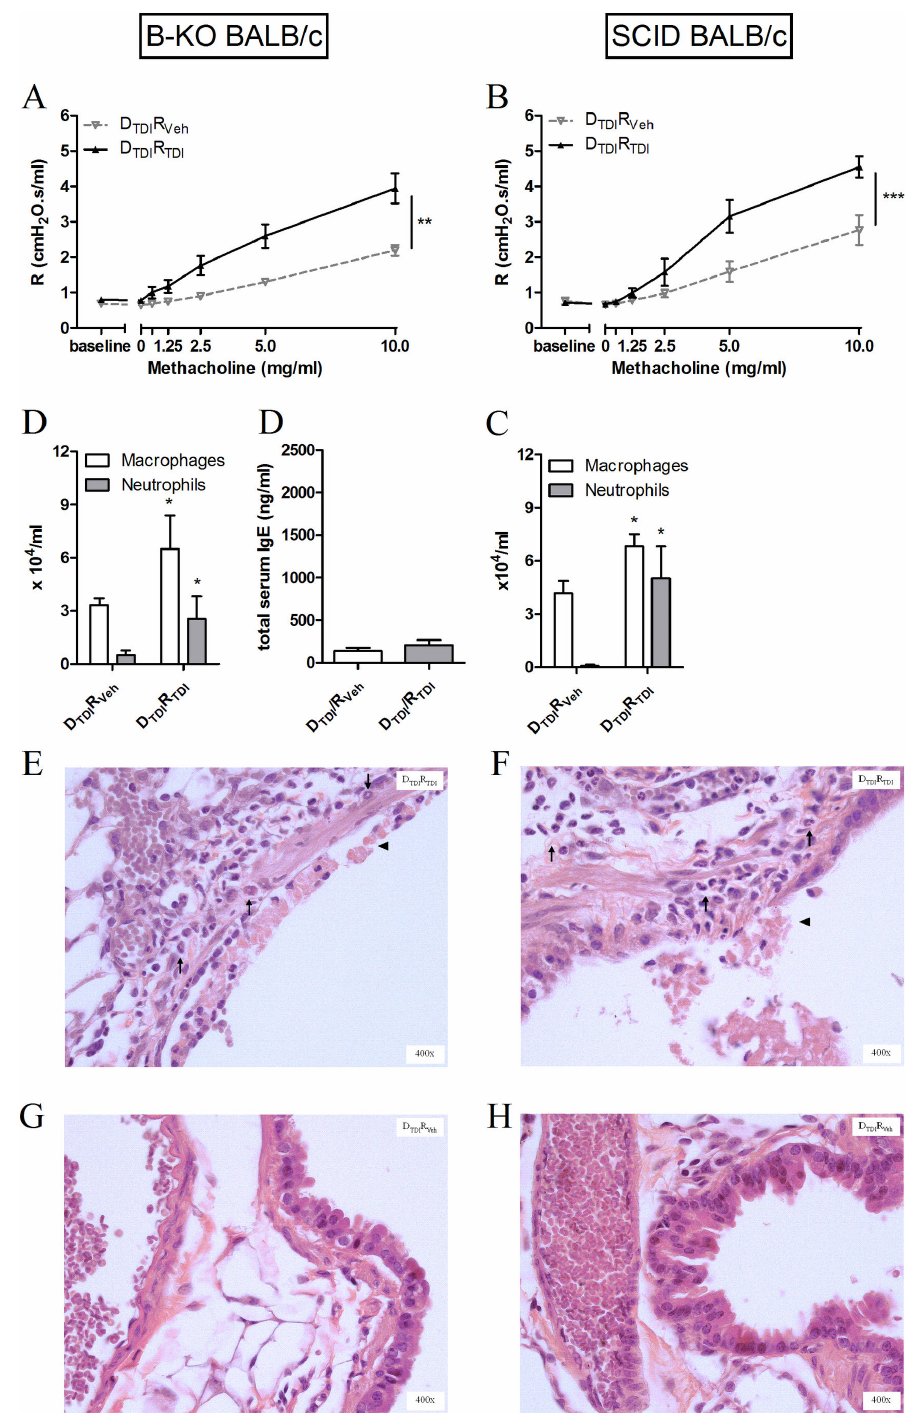
Figure 3. Transferring B-lymphocytes leads to an asthma-like response after TDI challenge in B-KO and SCID BALB/c mice. Airway methacholine reactivity was measured after transferring B-lymphocytes in B-KO (A) or SCID (F) mice. Macrophages and neutrophils were identified in the BAL fluid (B and G) and in lung tissue (D, E and H, I) 24 hours after the challenge. Total IgE was assessed in serum of B KO mice. Experimental groups for the adoptive transfer setup are identical to those of Figure 2 (DTDIRVeh and DTDIRTDI). Data are presented as means ± SEM, n = 5-8 per group, * p < 0.05, ** p < 0.01, *** p < 0.001 compared to the DTDIRVeh group. Symbols: (↑) inflammation and (▲) epithelial damage. doi: 10.1371/journal.pone.0083228.g003 PLOS ONE |